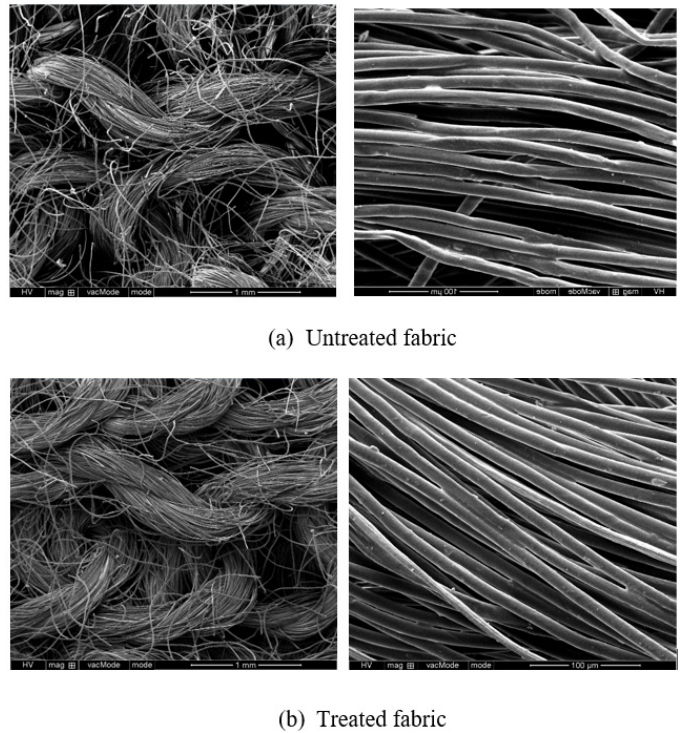
Figure 2. The knitted fabrics with non-finishing and hydrophilic finishing. ( a ) the surface of fabric and fibers are not smooth. ( b ) the surface of fabric and fibers are smooth. Table 1. The knitted fabric parameter (treated fabric had higher mass, lower thickness, and higher loop density due to the shrinkage of finishing).